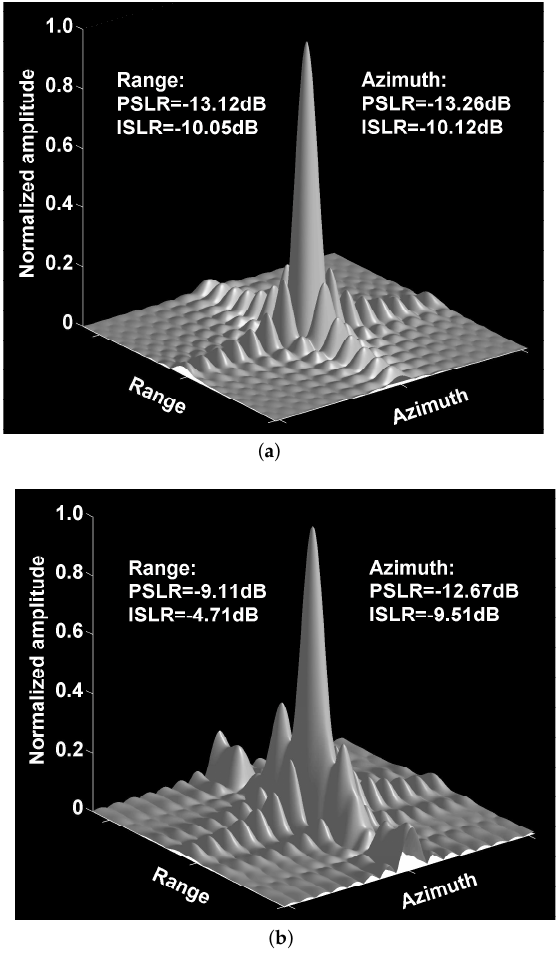
Figure 5. Imaging results of jamming and desired signals with respect to pointlike targets. ( a ) Target response of desired signal; ( b ) target response of jamming